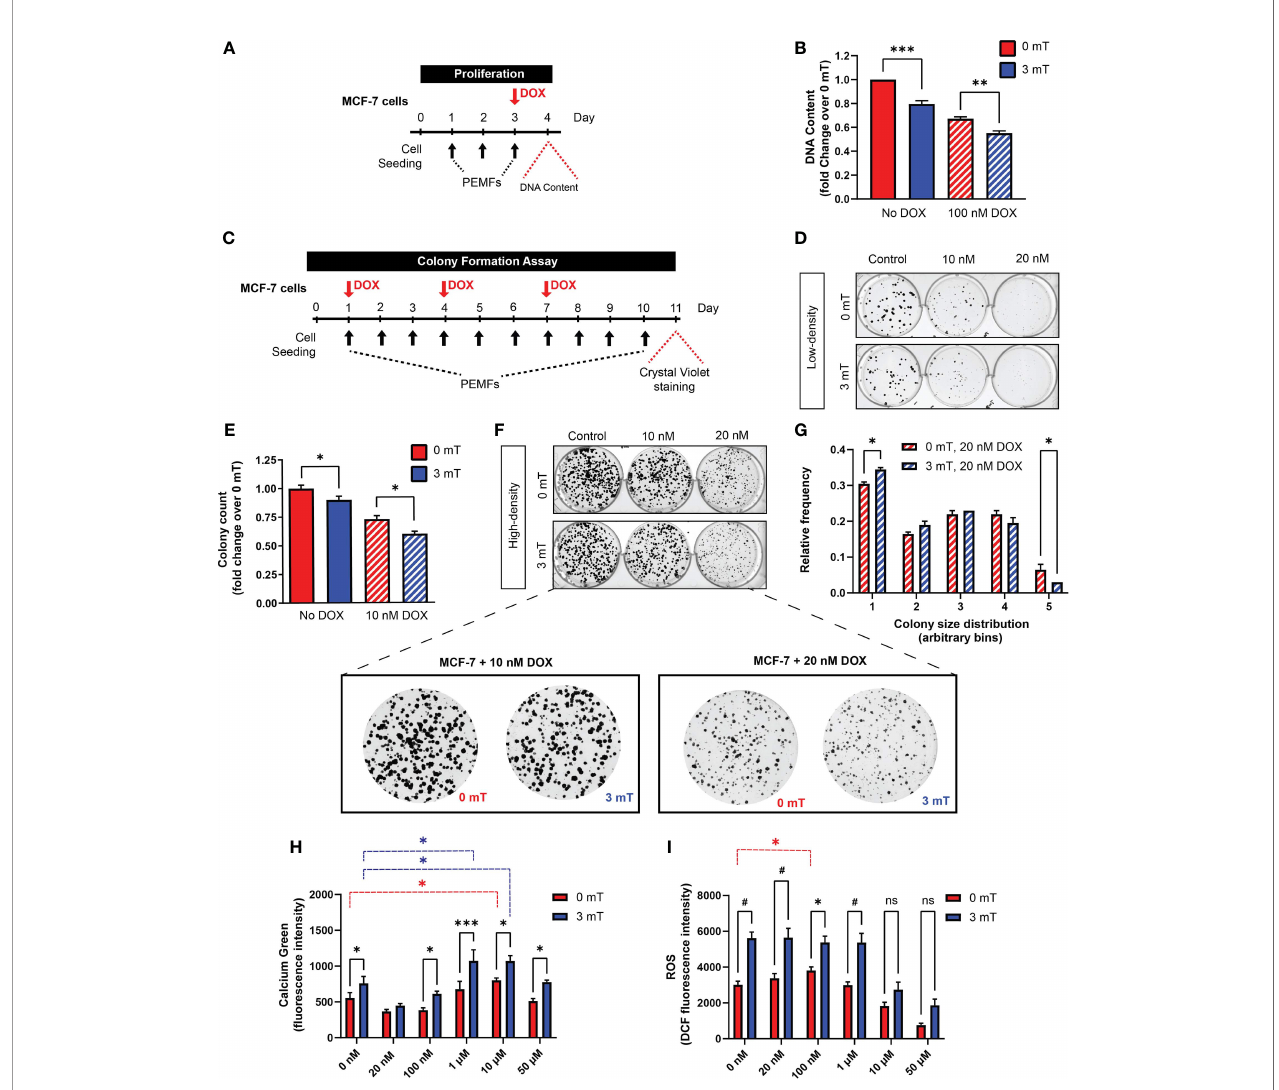
FIGURE 4 | PEMF exposure enhances MCF-7 cell vulnerability to doxorubicin. (A) Schematic of PEMF and DOX treatment regime for DNA quanti fi cation. Cells were exposed to 3 mT for 1 h daily for 3 successive days. DOX (100 nM) was administered on the fi nal day 1 h before the last PEMF exposure. Cellular DNA content was measured 24 h after the last PEMF exposure. (B) Quanti fi cation of pooled data for cellular DNA content represented as fold change 24 h post-DOX and PEMF treatments. (C) Colony formation paradigm for MCF-7 cells treated with DOX and PEMFs. (D) MCF-7 colony formation in the presence of 10 and 20 nM DOX, with and without PEMF exposure, as indicated. Cells were seeded at a density of 100 per well. (E) Colony survival in 10 nM DOX under low-density conditions. Colony survival in the presence of 20 nM DOX was too low to accurately quantify. (F) MCF-7 colony formation in the presence of 10 and 20 nM DOX, with and without PEMF exposure under high-density seeding condition of 1000 cells per well. ( F , below) Zoom-in images of cells under the DOX treatment paradigm. (G) Colony size frequency distribution in the presence of 20 nM DOX and 0 mT or 3 mT exposure, indicated by the red and blue hatched bars, respectively; high density cultures. (H) Absolute calcium fl uorescence intensity of MCF-7 cells treated with 16 h DOX at 20 nM, 100 nM, 1 m M, 10 m M and 50 m M. Cells were loaded with Calcium Green-1 and exposed to PEMFs for 30 min before rinsing, and fl uorescence determination 25 min later. (I) Absolute DCH 2 FDA-ROS fl uorescence from MCF-7 cells. Cells were similarly treated with DOX (20 nM, 100 nM, 1 µM, 10 µM and 50 µM) for 16 h before simultaneous incubation in DCH 2 FDA and exposure to PEMFs for 30 min. ROS measurement was performed every hour and data presented were from the 4 th hour. Calcium and ROS values represent the average of 7 technical replicates per condition. All data generated were from 3 to 5 independent experiments, with * p < 0.05, ** p < 0.01, *** p < 0.001 and # p < 0.0001. The error bars represent the standard error of the mean. “ ns ” indicates statistically nonsigni fi cant